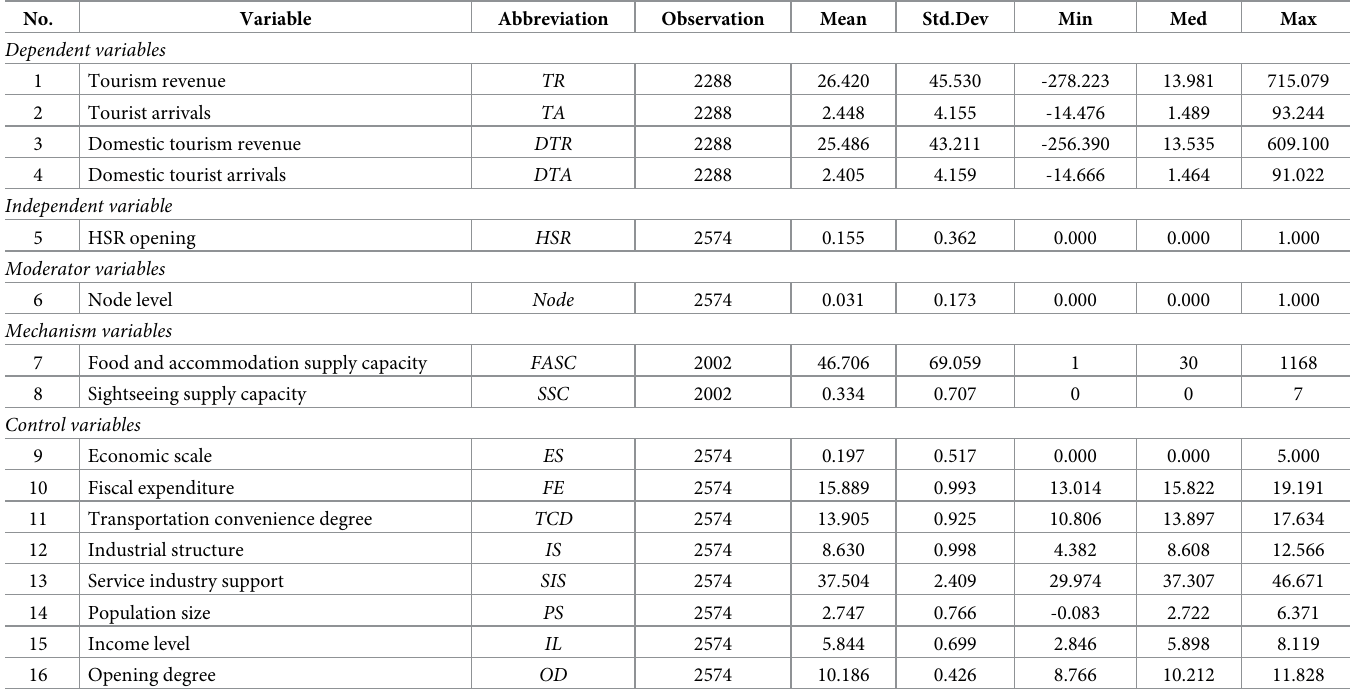
Table 1. Descriptive statistics of variables.